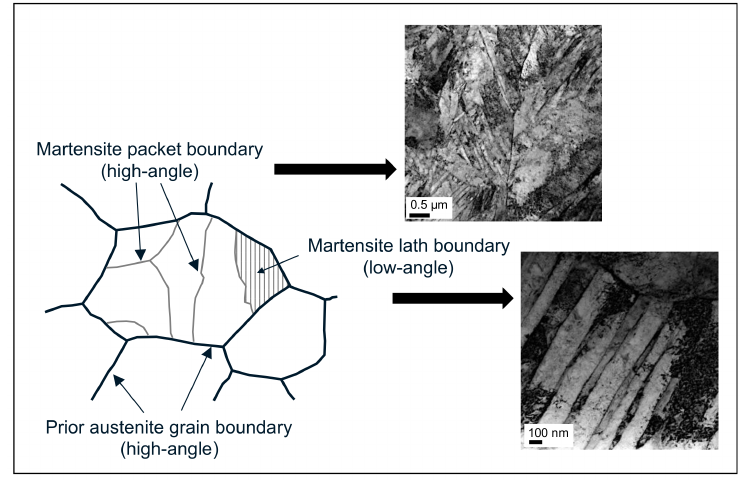
Figure 1. Microstructural features of low-carbon martensitic